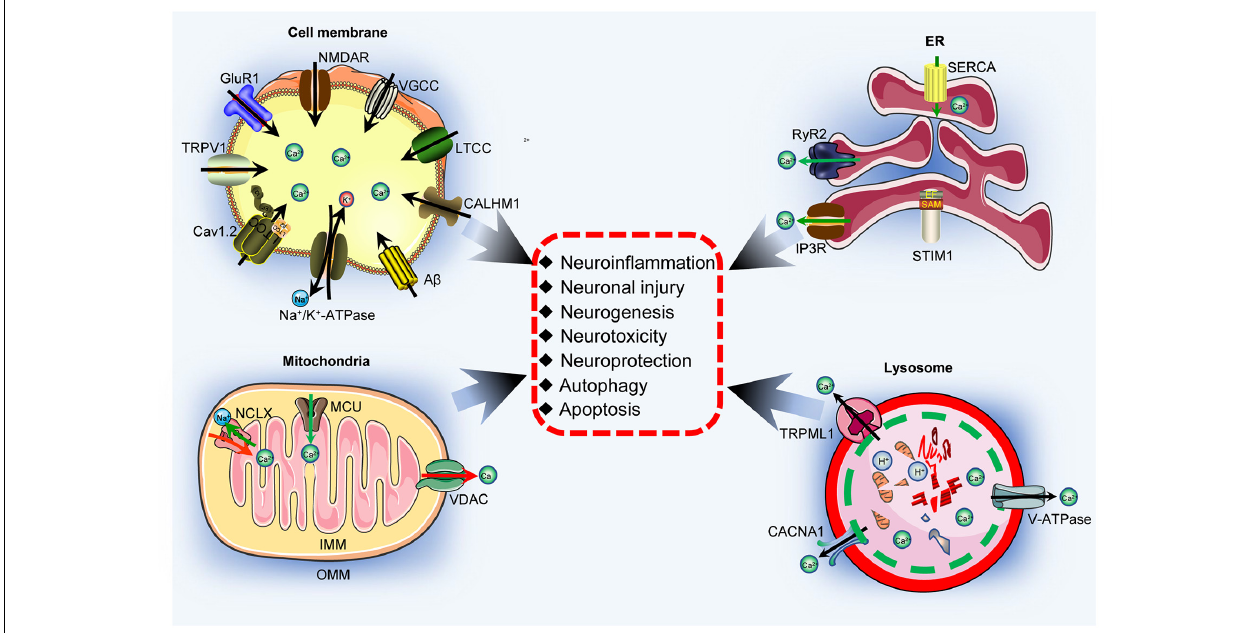
FIGURE 4 | Ca 2+ transporters are responsible for activating neuronal networks. Ca 2+ transporters located in the cell membrane, ER, mitochondria, and lysosome are responsible for regulating neuroinflammation, neuronal injury, neurogenesis, neurotoxicity, neuroprotection, autophagy, and